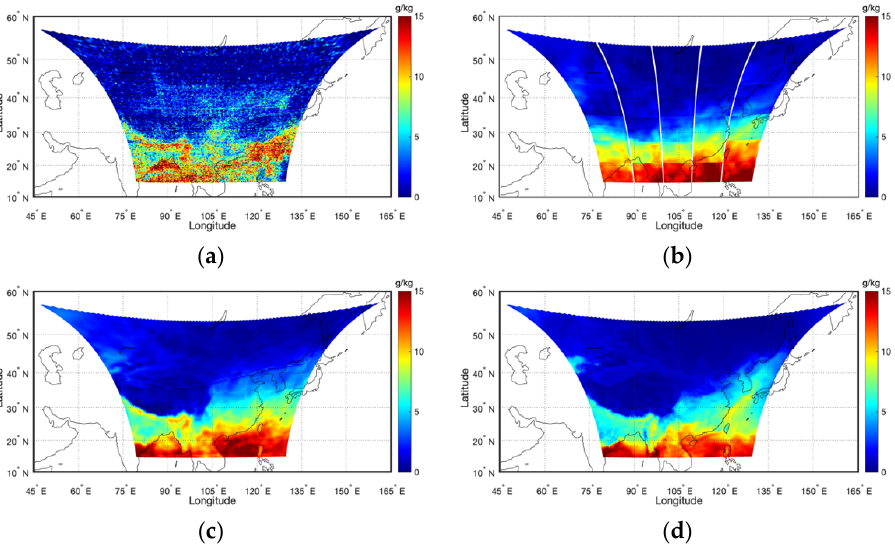
Figure 8. Water vapor mixing ratio (unit: g/kg) at 1000 hPa from 00 to 01 (UTC) on 01 February 2021: